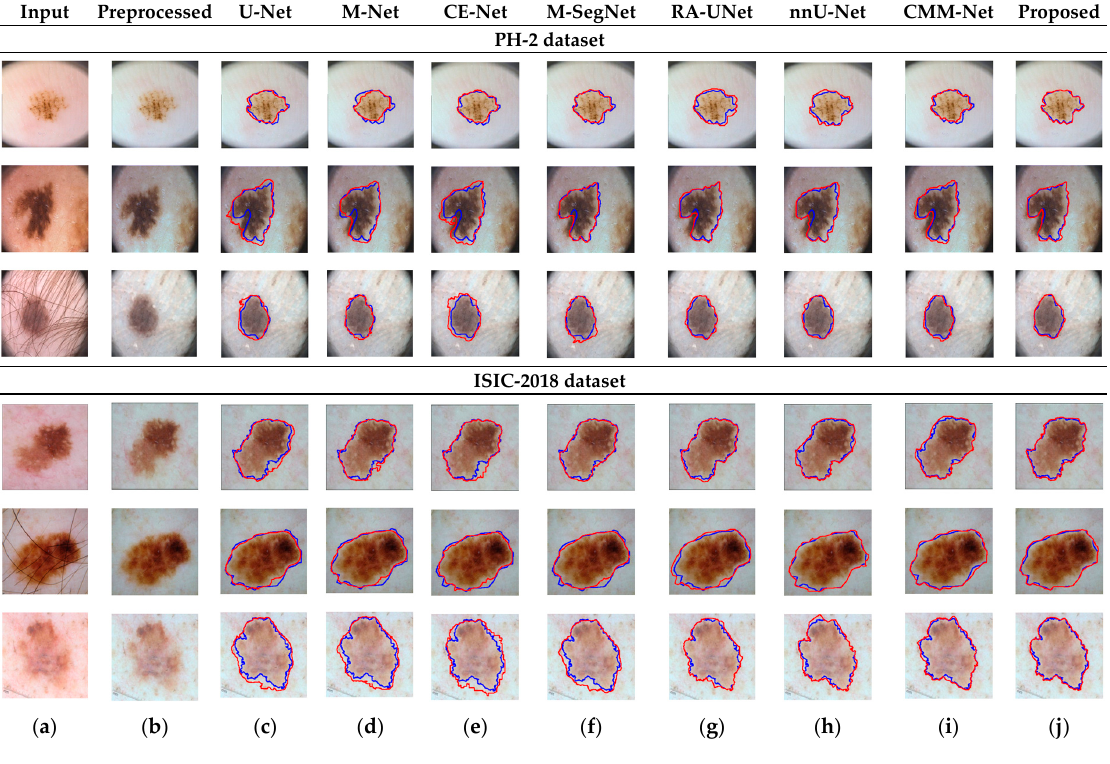
Figure 4. Qualitative comparison of the proposed method and conventional methods for a skin-lesion dataset. From left to right: ( a ) original input images; ( b ) preprocessed images; ( c – j ) input images with the overlay of ground truth (blue contour) and predicted outputs (red contour) indicating the segmentation results obtained by U-Net, M-Net, CE-Net, M-SegNet, RA-UNet, nnU-Net, CMM-Net, and the proposed method, respectively.